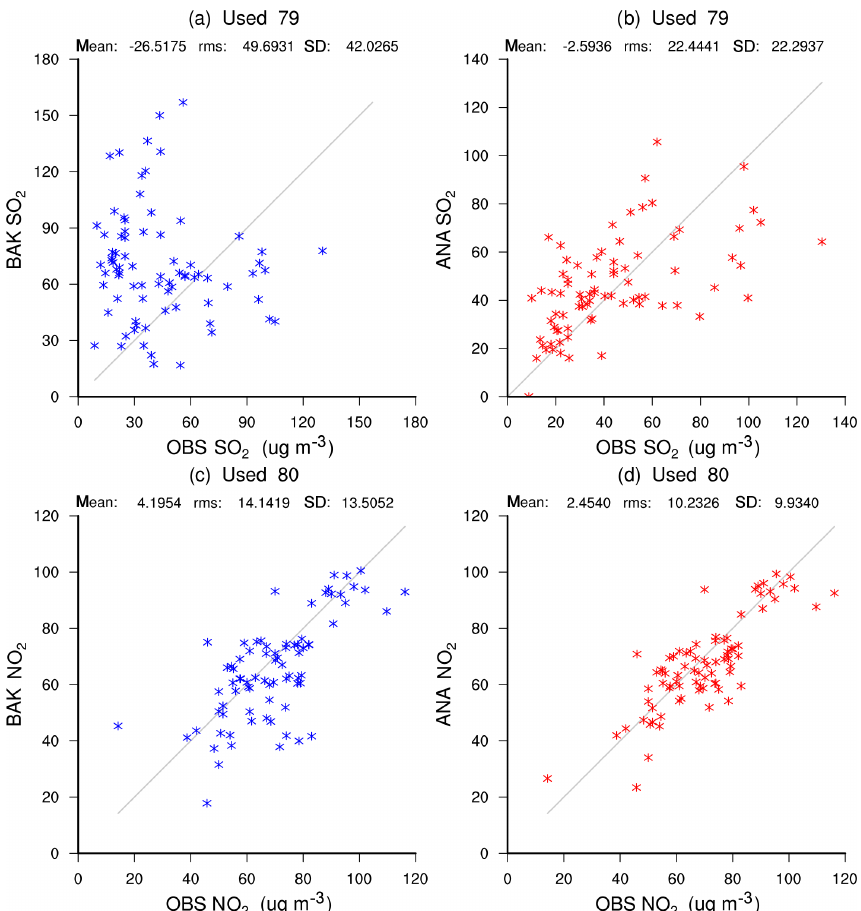
Figure 14. Averaged scatterplot of (a, c) observation versus background and (b, d) observation versus analysis for (a, b) SO 2 and (c, d) NO 2 around the Beijing area (red dots in Fig. 1) on 16 January. The numbers above the panels denote the accumulated numbers of the observations used around the Beijing area on 16 January (16:00, 16:06, 16:12, and